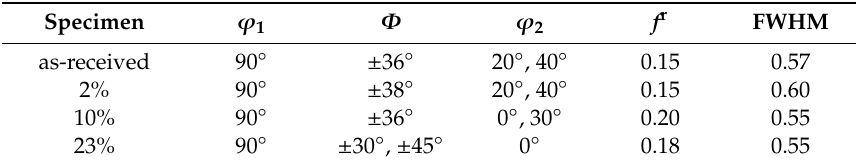
Table 2. The , and Eulerian angles of the ideal orientation of the major texture components, the volume fraction of the random texture component and the FWHM describing the orientation spread of the major texture components calculated by X-TEX.